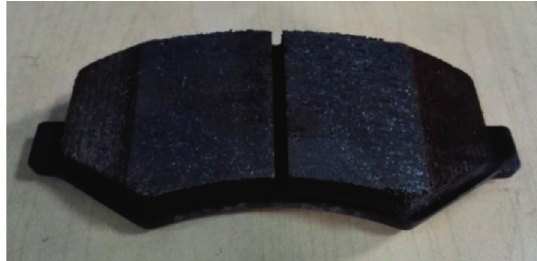
Figure 13: Brake lining after optimization. Table 6: Noisy stops with the original and optimized